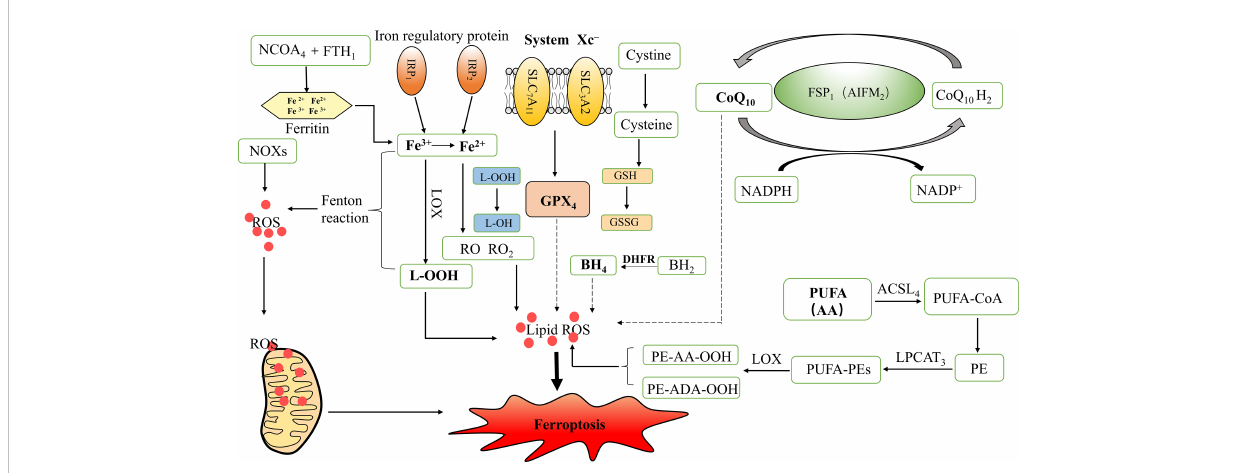
FIGURE 1 Mechanism of ferroptosis and iron metabolism. ROS, Reactive oxygen species; GPX 4 , Glutathione peroxidase 4; L-OOH, Lipid hydroperoxides; L-OH, Alcohol; RO, Alkoxy; RO 2 , Peroxy; IRP 1 , Iron regulatory protein 1; IRP 2 , Iron regulatory protein 2; LOX, Lipoxygenase; NADPH, Nicotinamide adenine dinucleotide phosphate; NOXs, NADPH Oxidases; GSH, Glutathione; GSSG, Oxidized GSH; SLC 7 A 11 , Solute carrier family 7 members 11; SLC 3 A 2 , Solute carrier family 3 member 2; CoQ 10 , Coenzyme Q 10 /Ubiquinone; CoQ 10 H 2 , Ubiquinol; FSP 1 , Ferroptosis suppressor protein 1; AIFM 2 , Apoptosis inducing factor mitochondrial associated 2; BH 4 , Tetrahydrobiopterin; BH 2 , Dihydrobiopterin; DHFR, Dihydrofolate reductase; PUFA, Polyunsaturated fatty acids; AA, Arachidonic acid; ADA, Adrenic acid; PE, Phosphatidyl ethanolamine; ACSL 4 , Acyl CoA synthase long-chain family member 4; LPCAT 3 , lysophosphatidylcholine acyltransferase 3; PUFA-CoA, Polyunsaturated fatty acid acyl-coenzyme A; PUFA-PEs, PUFA- phosphatidyl ethanolamines; NCOA 4 , Nuclear receptor co-activator 4; FTH 1 , Ferritin heavy